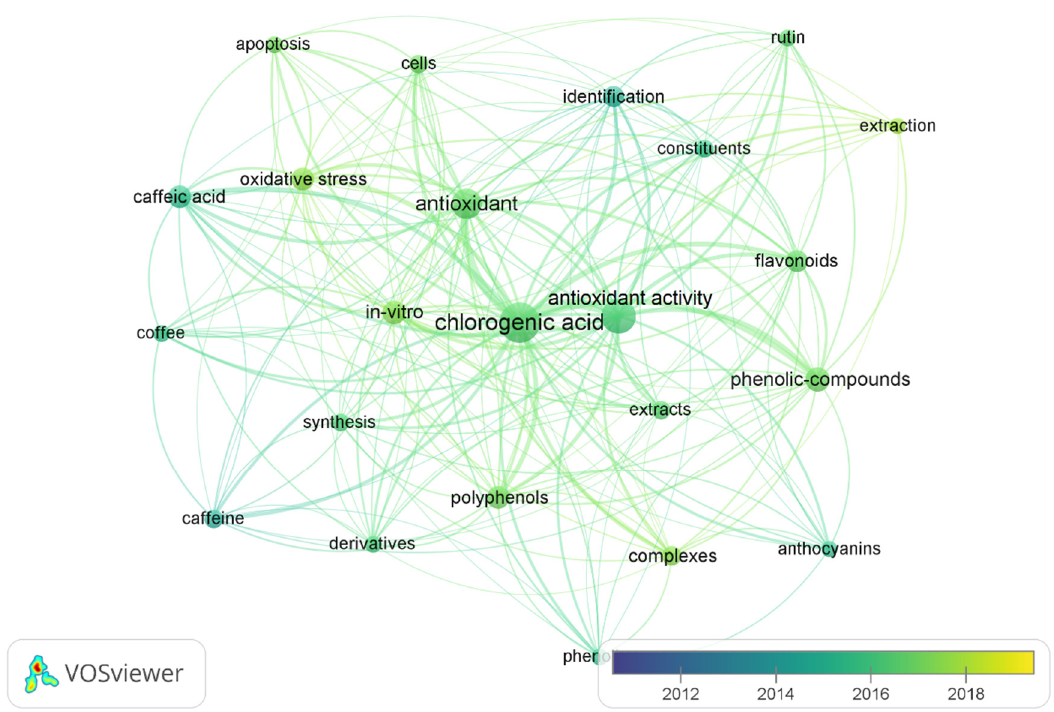
Figure 2. Co-occurrence of selected keywords in articles in 2010–2022 (search terms: “chlorogenic acid”, “antioxidant”), created with VOSviewer [44].